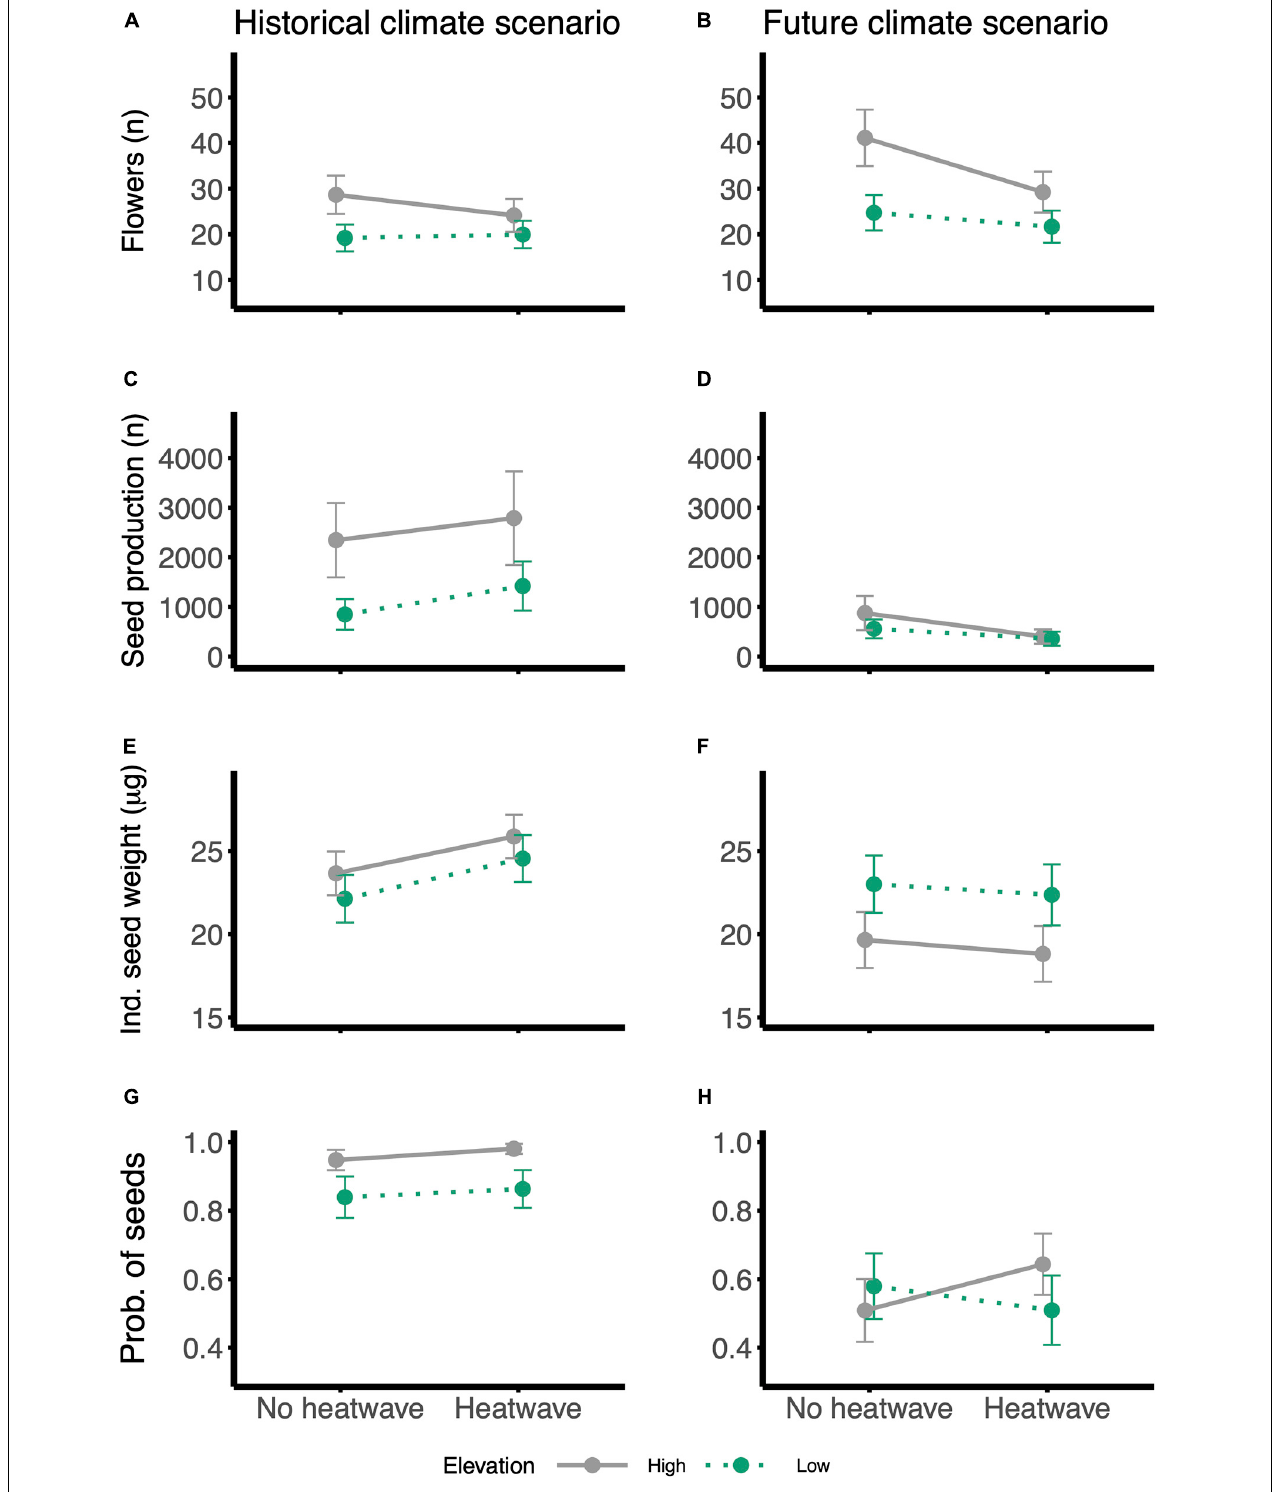
FIGURE 5 | Reaction norms for fitness traits in response to the heatwave treatment: (A,B) number of flowers, (C,D) total seed production, (E,F) individual seed weight and (G,H) probability of producing any seeds. Panels on the left: historical climate scenario; panels on the right: future climate scenario. Gray and solid lines = high-elevation families; green and dotted lines = low-elevation families. Values were estimated from the models using the emmeans function in ‘emmeans’ package, in R; error bars are standard errors. Ind., individual; prob., probability.